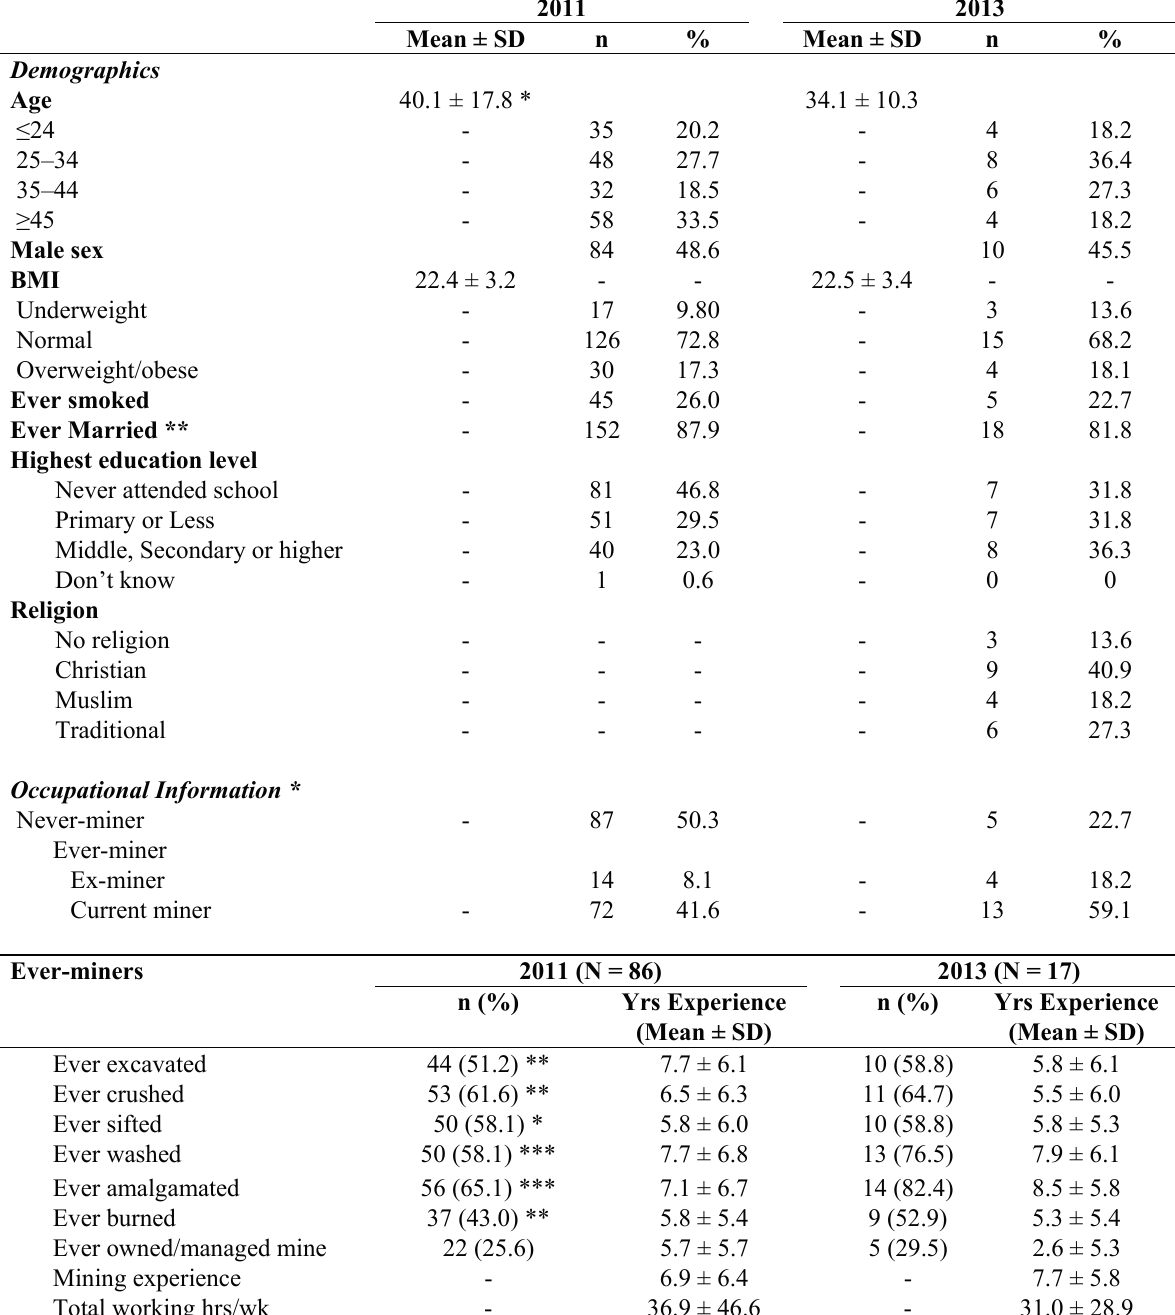
Table 1. Demographic and occupational information for 2011 (N = 173) sample and 2013 subsample (N =